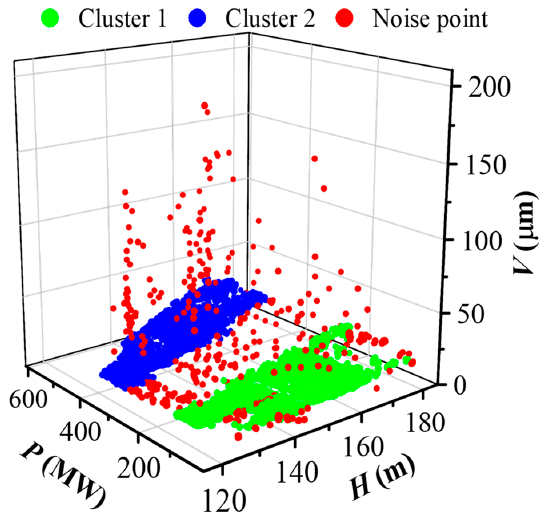
Figure 10. Clustering result of